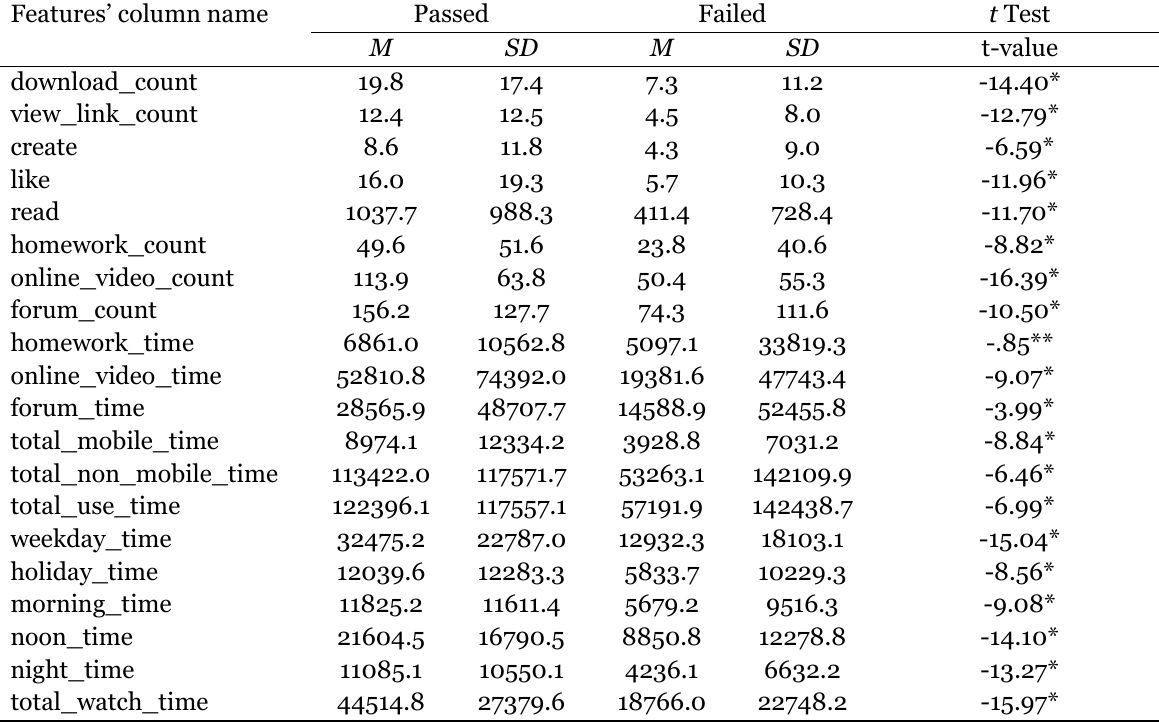
Table 5 Descriptive Statistics of